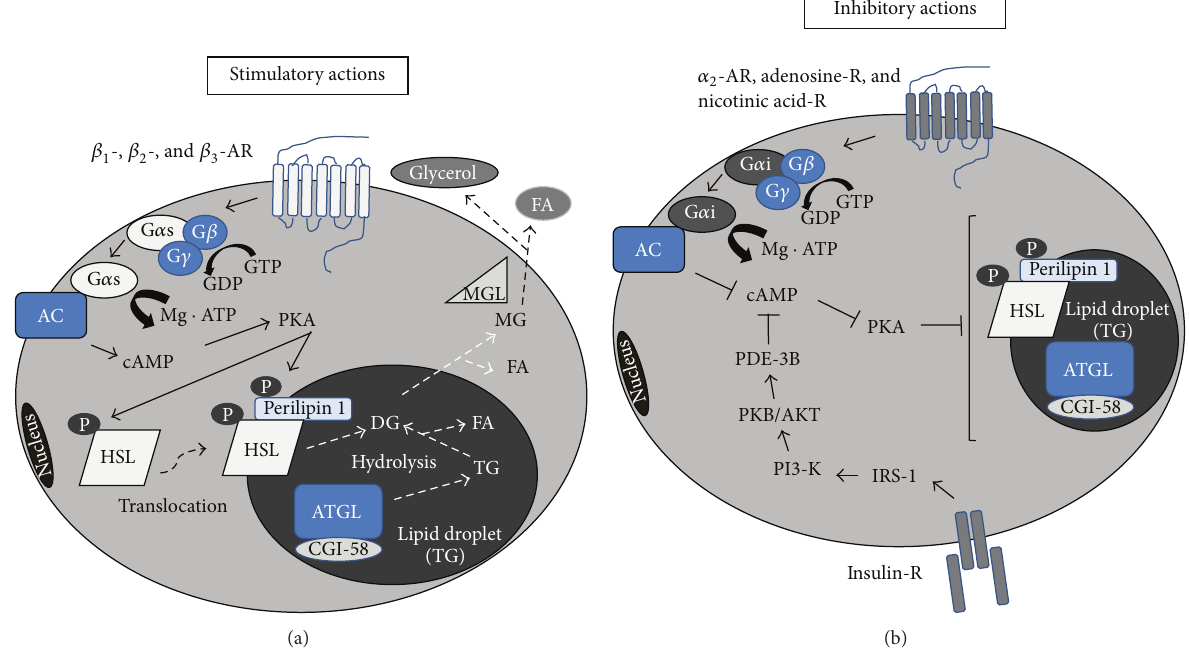
Figure 1: Lipolysis in white adipocytes is mainly regulated through GPCRs that localize on the plasma membrane. (a) Under stimulatory conditions, ligands binding to GPCRs, that is, 𝛽 1 -, 𝛽 2 -, and 𝛽 3 -AR, activate AC through the action of G 𝛼 s, resulting in an increase in PKA activity through the accumulation of intracellular cAMP, and, in turn, PKA phosphorylates and activates HSL. Phosphorylated HSL translocates on the lipid droplet and thereby activates lipolysis. (b) On the other hand, ligands binding to GPCRs, that is, 𝛼 2 -AR, adenosine- R, and nicotinic acid-R, attenuate lipolysis via a reduction in cAMP production. Insulin receptor signaling also inhibits lipolytic response via the activation of PDH-3B, a cAMP-degrading enzyme.